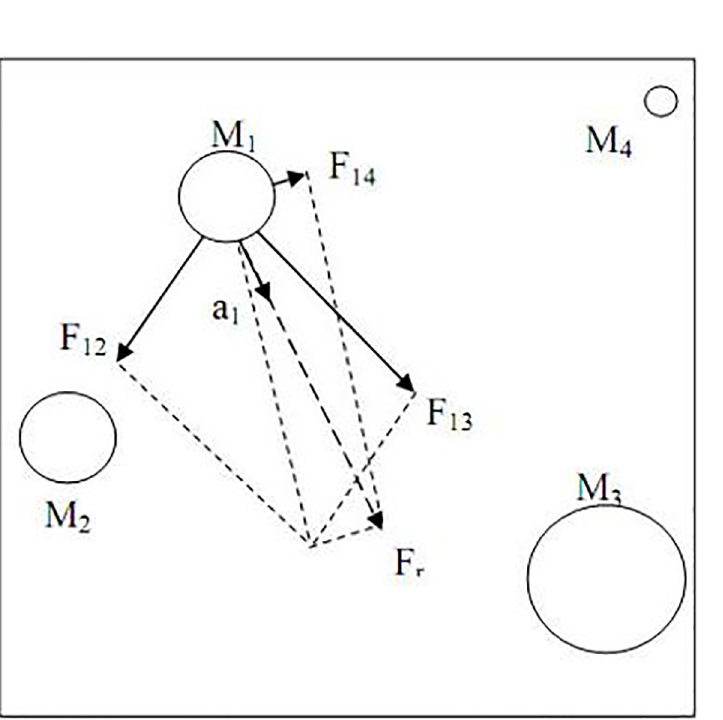
Fig 1. Mass acceleration toward the result force in GSA